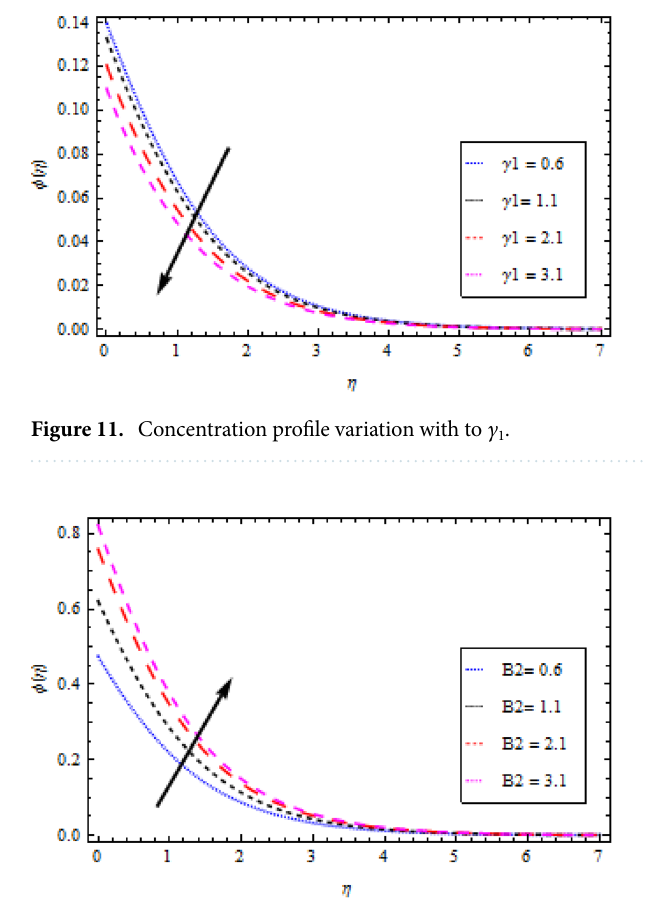
Figure 12. Concentration profile variation with respect to B 2